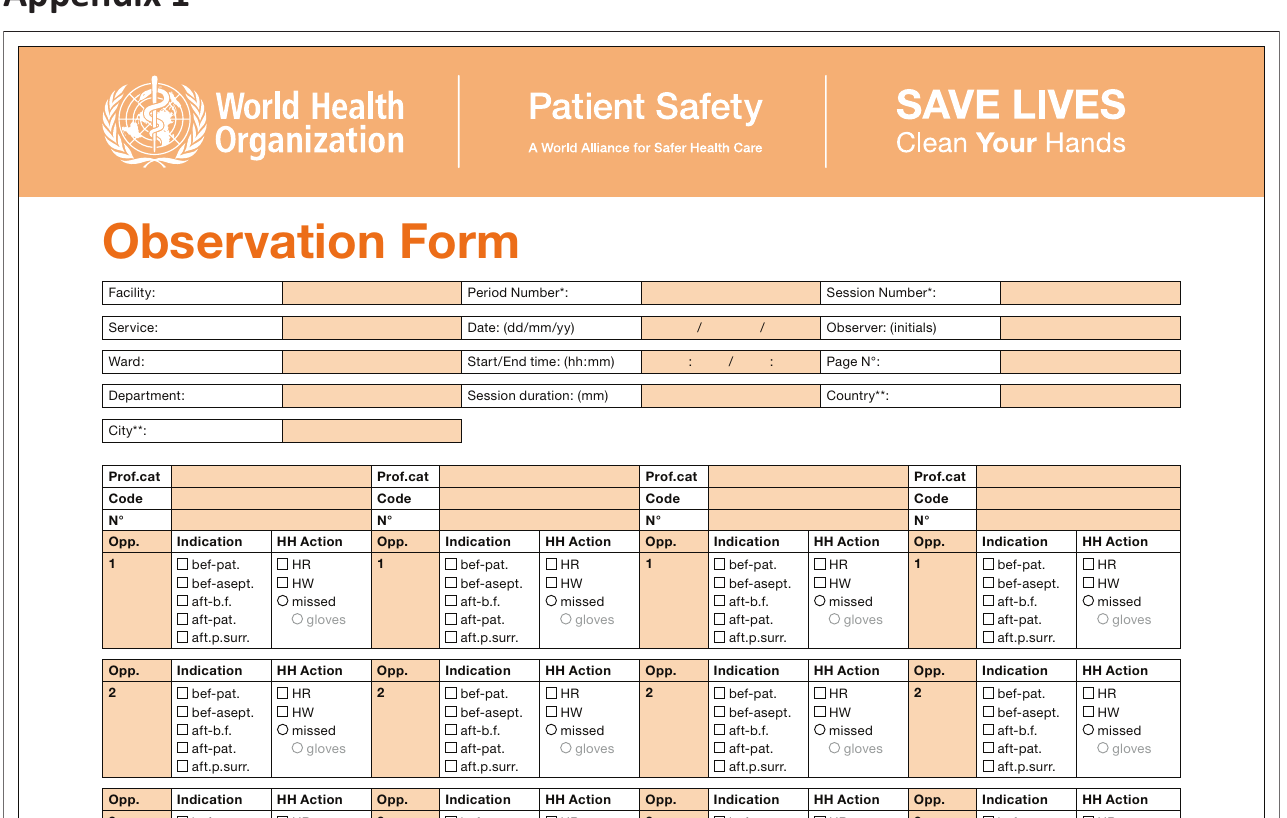
1 bef-pat. HR HW bef-asept. missed aft-b.f. gloves aft-pat. aft.p.surr. bef-pat. bef-asept. missed aft-b.f. gloves aft-pat. aft.p.surr. 3 bef-pat. HR HW bef-asept. missed aft-b.f. gloves aft-pat. aft.p.surr. 4 bef-pat. HR HW bef-asept. missed aft-b.f. gloves aft-pat. aft.p.surr. 5 bef-pat. HR HW bef-asept. missed aft-b.f. gloves aft-pat. aft.p.surr.